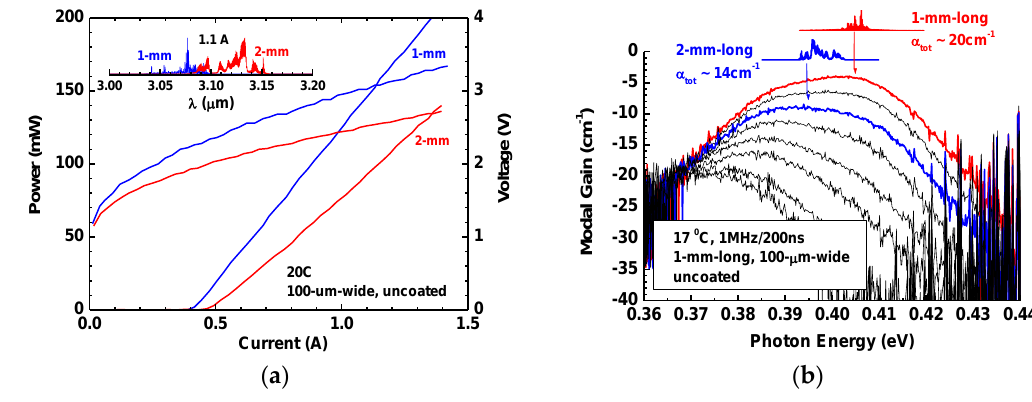
Figure 3. ( a ) Short pulse light-current-power conversion characteristics measured at 20 °C for 100-μm-wide, 1-mm-long, uncoated three-stage cascade lasers. Insert shows the device’s emission spectra. ( b ) Modal gain spectra measured by the Hakki-Paoli method for 1-mm-long, uncoated wide-gain three-stage cascade diode lasers under pulsed excitation (200 ns/1 MHz). Inserts show the emission spectra of free-running Fabry-Perot lasers with 1- and 2-mm-long cavities, hence requiring different threshold gains.